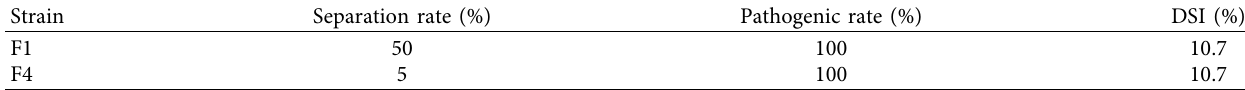
Table 2: Separation rate of pathogenic fungi of kiwifruit fruit rot and pathogenic rate and DSI of pathogenicity test.